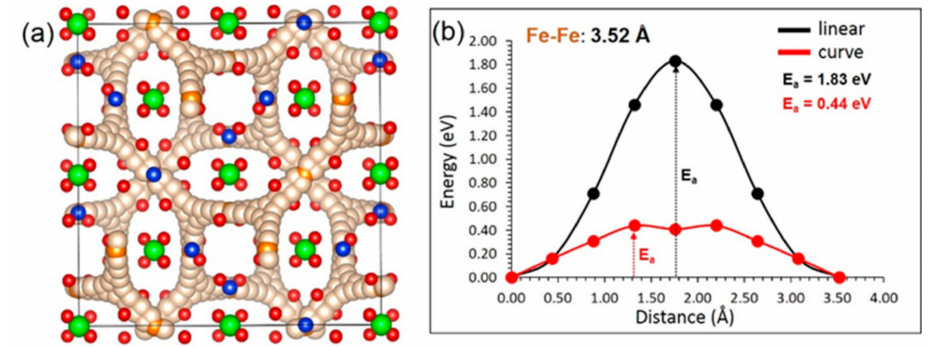
Figure 3. ( a ) Three-dimensional Fe-ion migration pathway and ( b ) energy profile diagram showing activation energies for both linear and curved